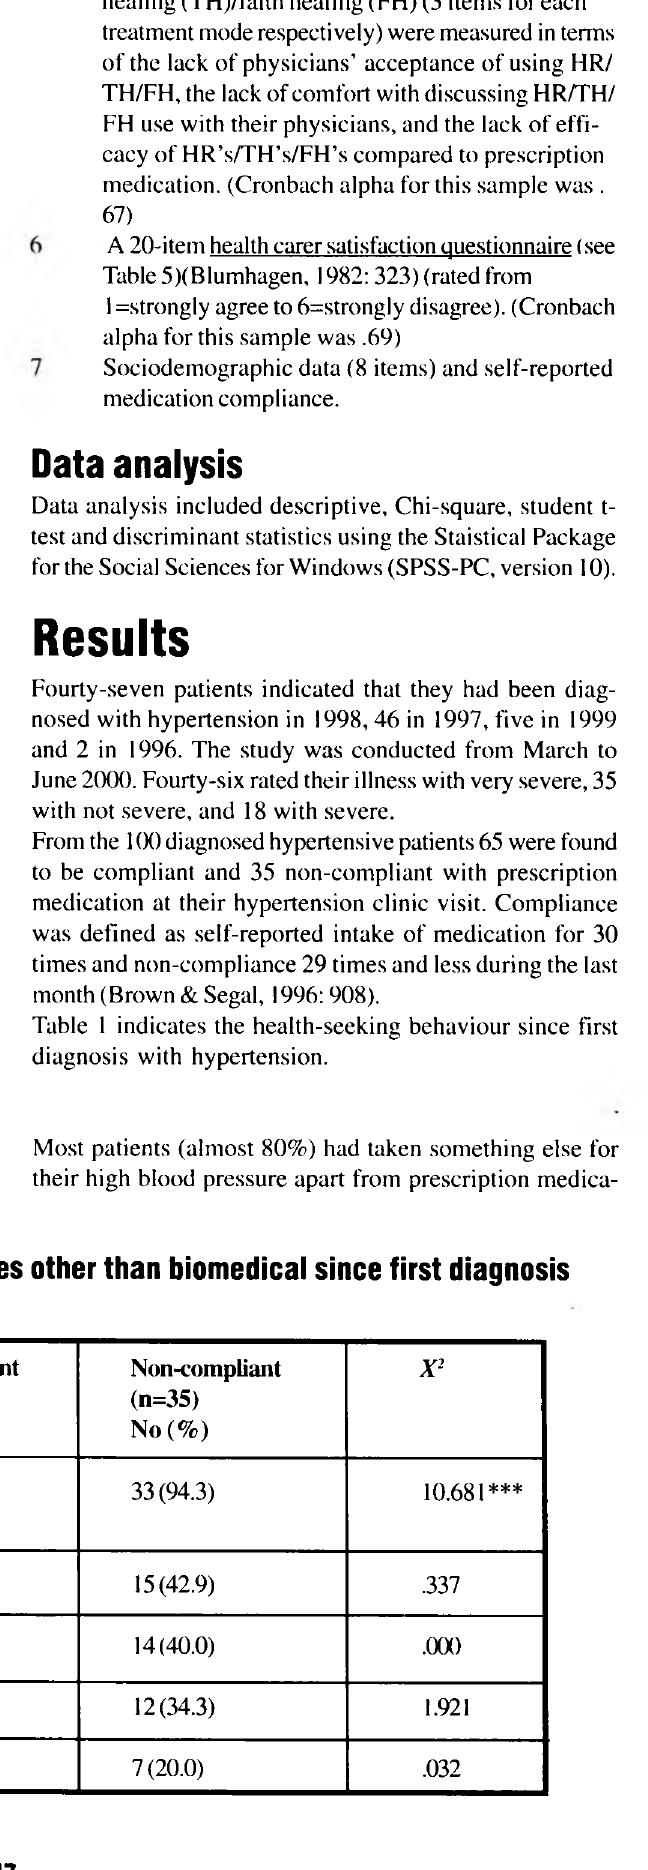
Help-seeking for